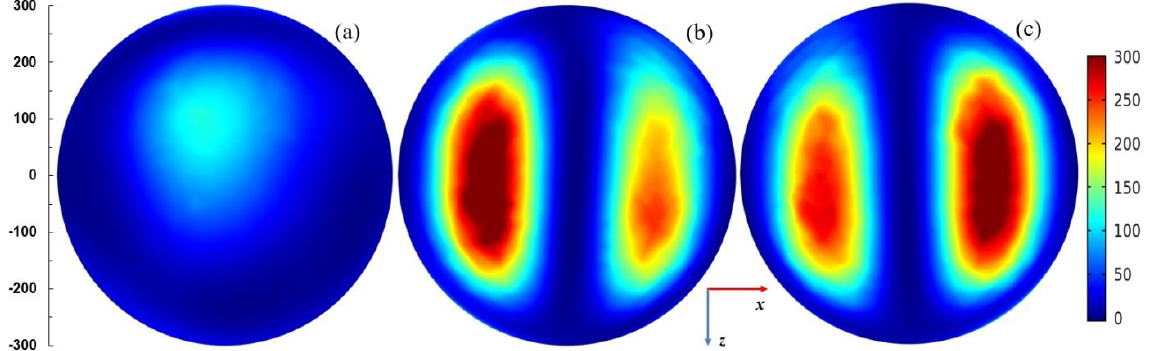
Figure 8. Distributions of the power flux W /(1 W/m 2 ) on the upper part of the radiation sphere (with radius 300 mm) for P ent = 100 W. ( a ) L = 15 mm, ( b ) L = 25 mm, and ( c ) L = 35 mm. The coordinate system the same as in Figure 4. The scale on the left shows dimensions in mm.